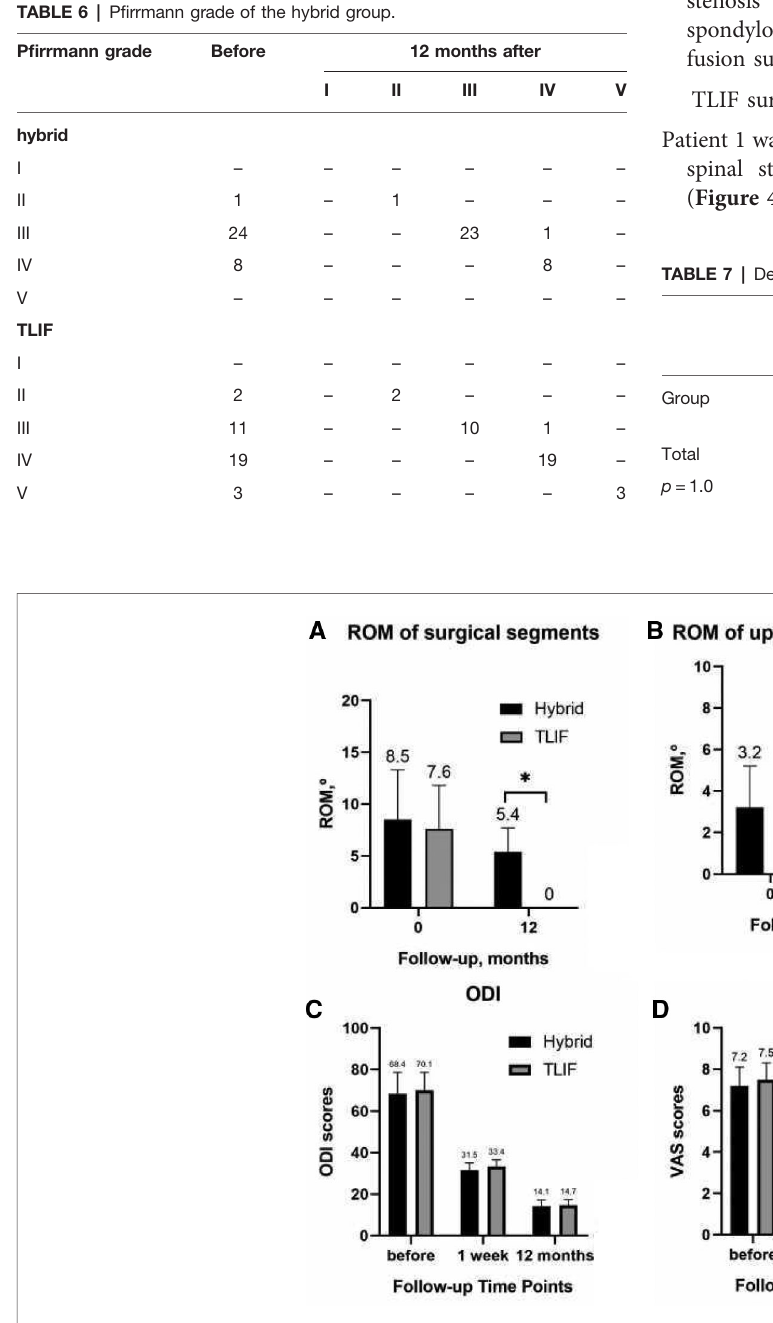
FIGURE 2 | ROM of surgical segments before and 12 months after surgery. ( A ) ROM of the upper adjacent segment before and 12 months after surgery; ( B ) ODI scores; ( C ) VAS; and ( D ) for patients.